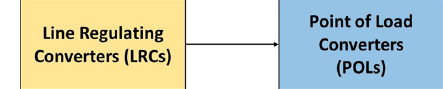
Fig. 2 Power converter interface stages of DC distribution